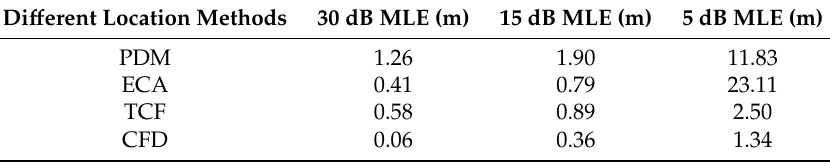
Table 3. Comparison of MLE values for different location methods at d = 250 m.